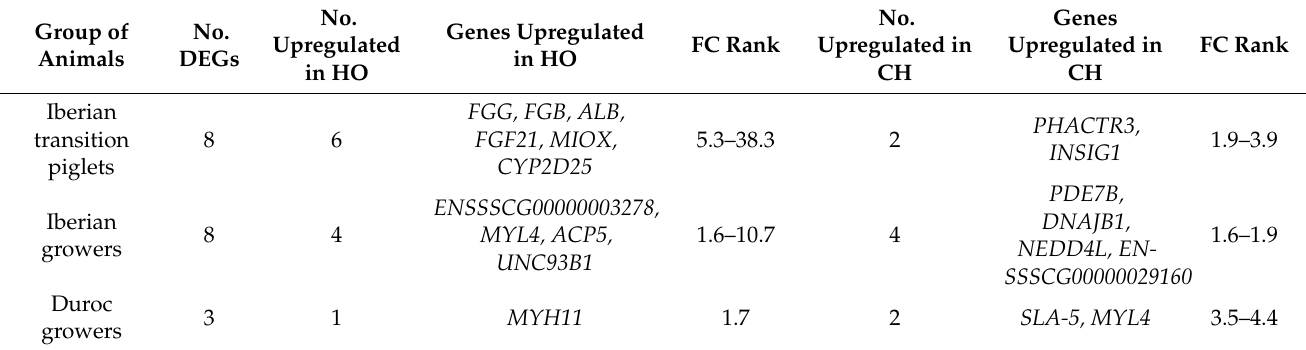
Table 7. Summary of differential expression results for the diet effect on